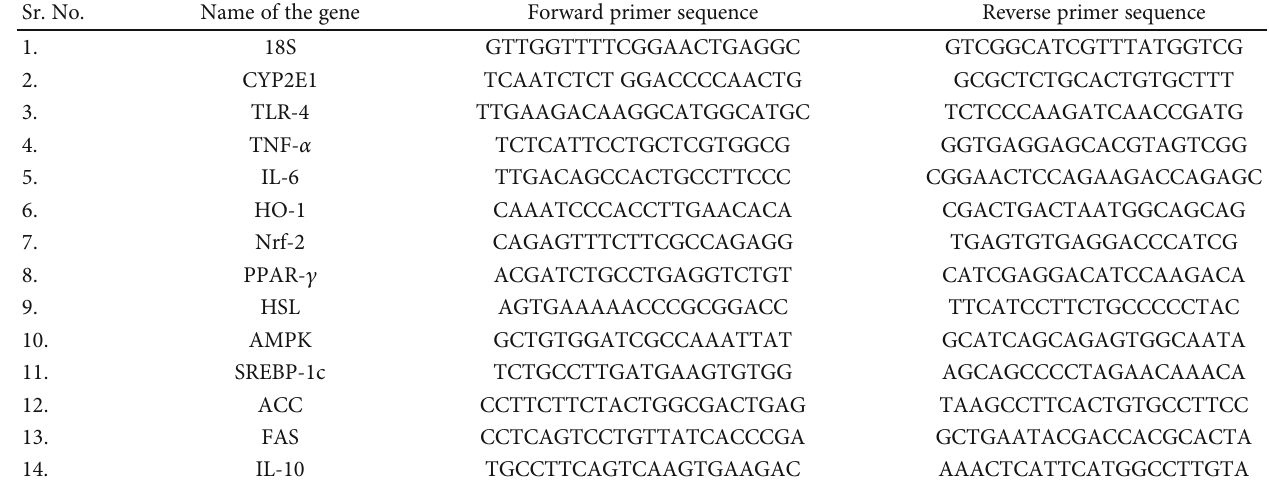
Table 3: The list of Rattus norvegicus primers used for quanti fi cation of mRNA expression levels in qRT-PCR. Sr.